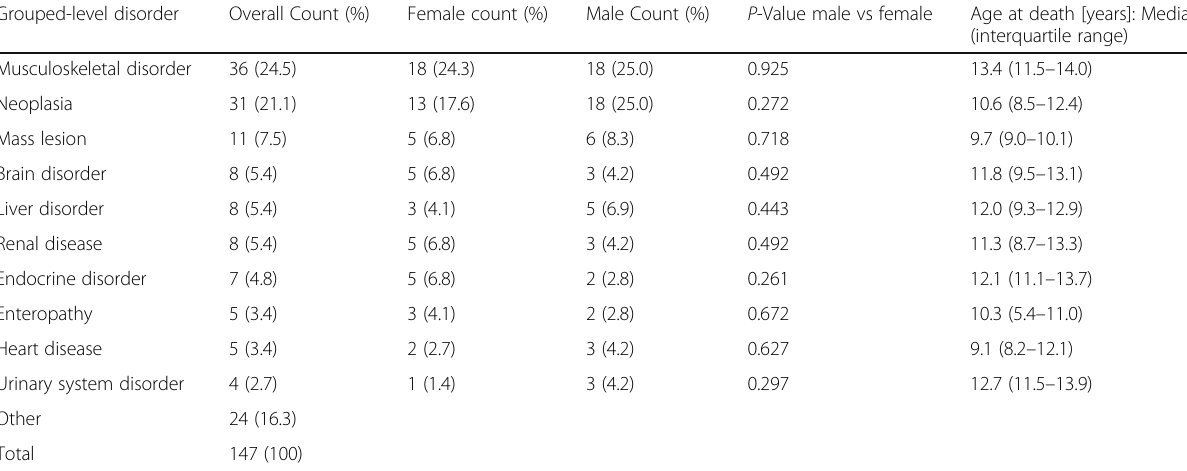
The P -value reflects comparison between the prevalence in females and males